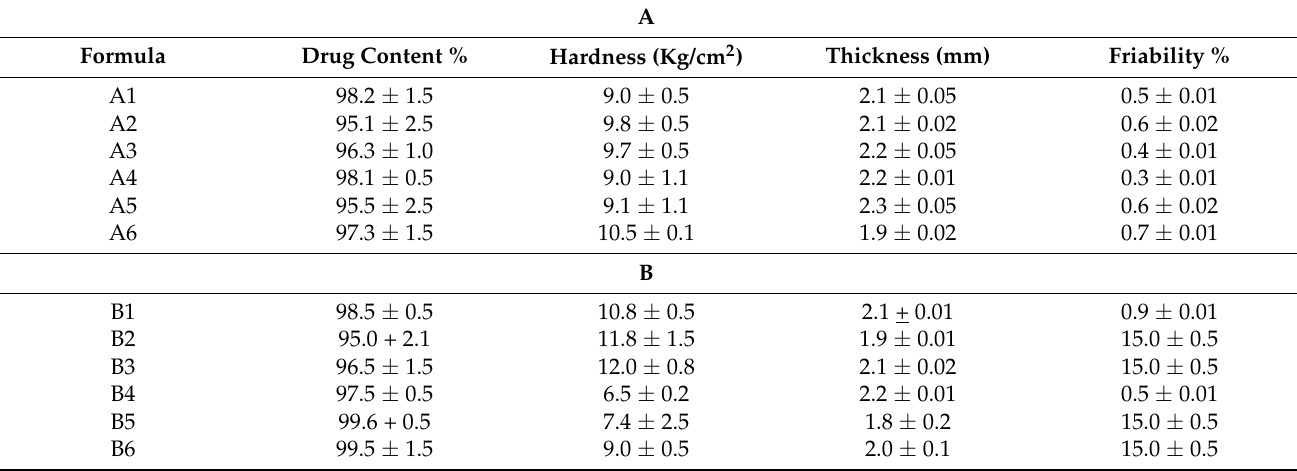
Table 3. Characterization of different batches of formulations.